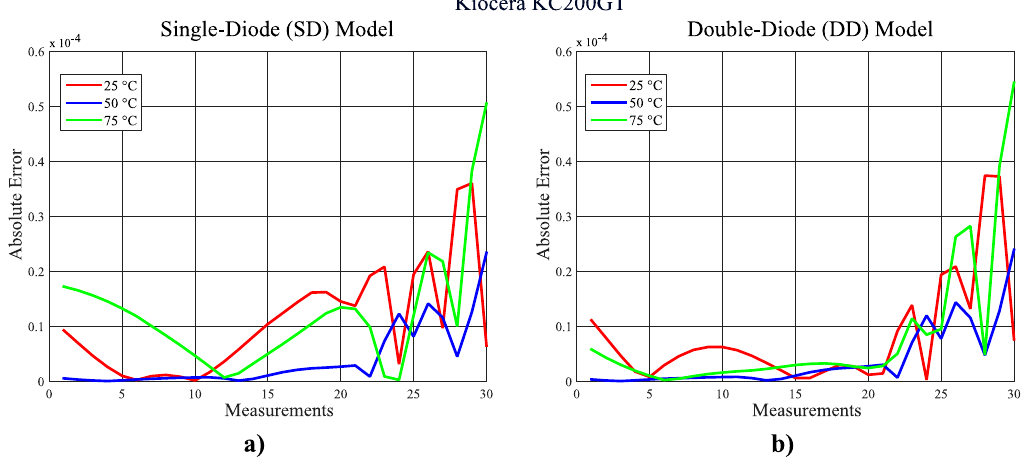
Figure 12. Absolute error curves between the measured and experimental I-V data at different cell temperatures (25, 50 and 75 ◦ C) and fixed solar irradiance ( G = 1000 W/m 2 ) for an individual cell from a Kyocera KC200GT Solar Panel. ( a ) SD model and ( b ) DD model.